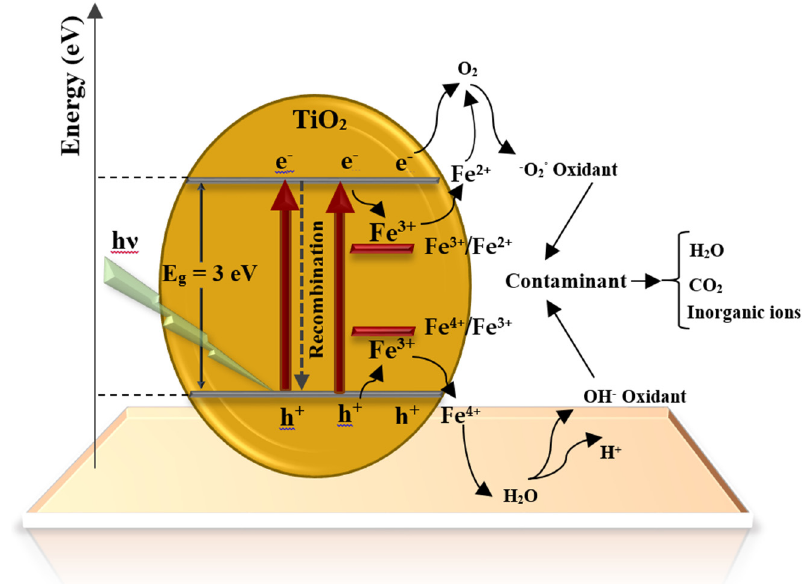
Figure 11. Schematic display of the electronic band structure of Fe/TiO 2 –7.